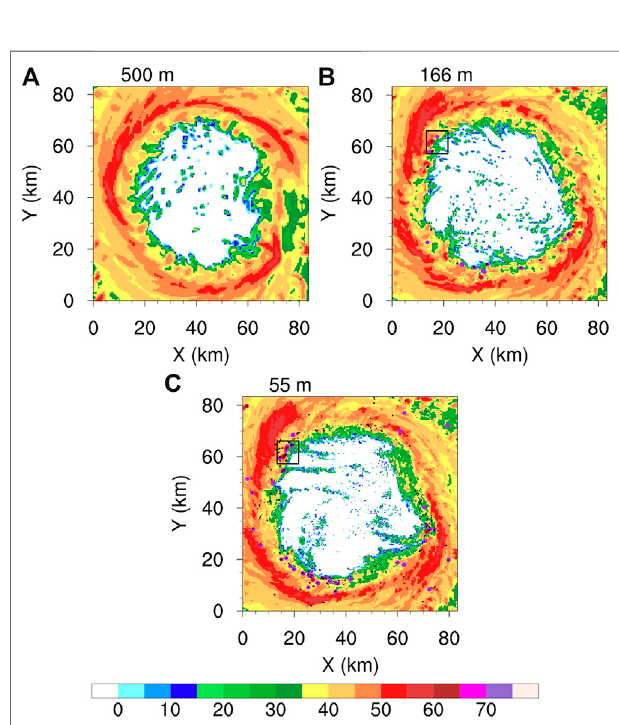
FIGURE 9 | The simulated radar re fl ectivity (dBZ) with vertical maximum vorticity > 0.2 m s − -1 or 0.1 m s − 1 (black contour), w > 15 m s − 1 (purple contour) and w > 20 m s − 1 (red contour) at t (cid:2) 9 h of the simulation from the grid spacings of (A) 500 m, (B) 166 m and (C) 55 m, respectively.